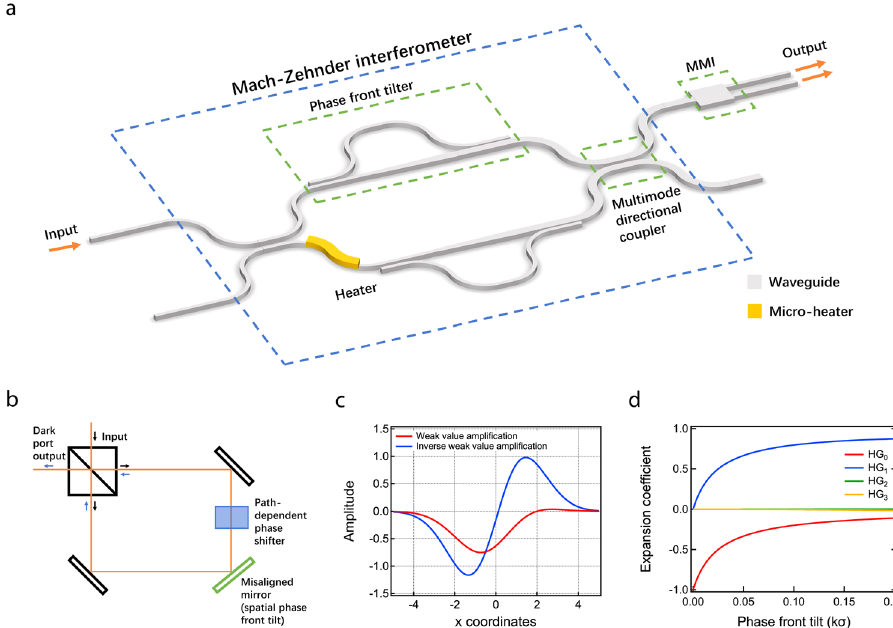
Fig. 1 Device schematic and free space weak value ampli fi cation. a Schematic of on-chip weak value device consisting of an MZI with phase front tilters and MMI as readouts. The heater is to apply a phase shift to the waveguides. b Free space Sagnac interferometer with weak value ampli fi cation. c Beam pro fi le of free space dark port in weak value ampli fi cation (red) and inverse weak value ampli fi cation (blue) setup with respect to detector coordinates. In the inverse weak value regime, the beam pro fi le resembles an HG 1 mode, while in the weak value regime, it resembles an HG 0 mode. d Hermite-Gaussian expansion coef fi cients of the inverse weak value ampli fi cation beam pro fi le in Fig.